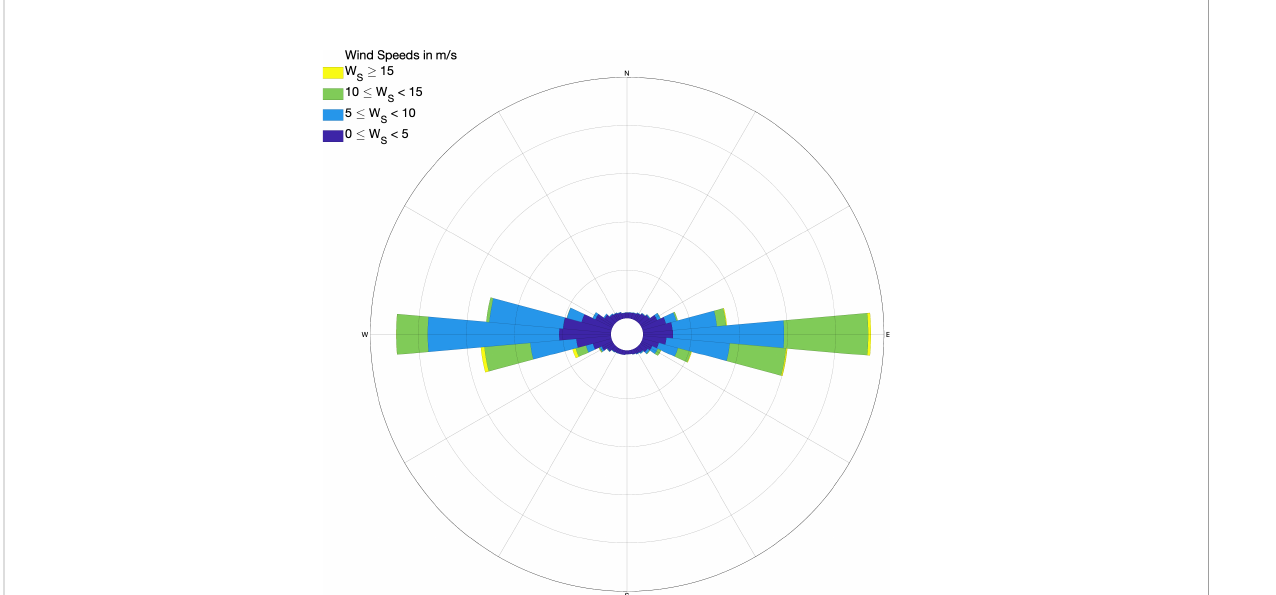
FIGURE 8 Wind rose at 10 m altitude in central Alboran, for the period 1979 – 2010 (from the “ ERA5 hourly data on single levels from 1979 to present ” dataset; Hersbach et al.,